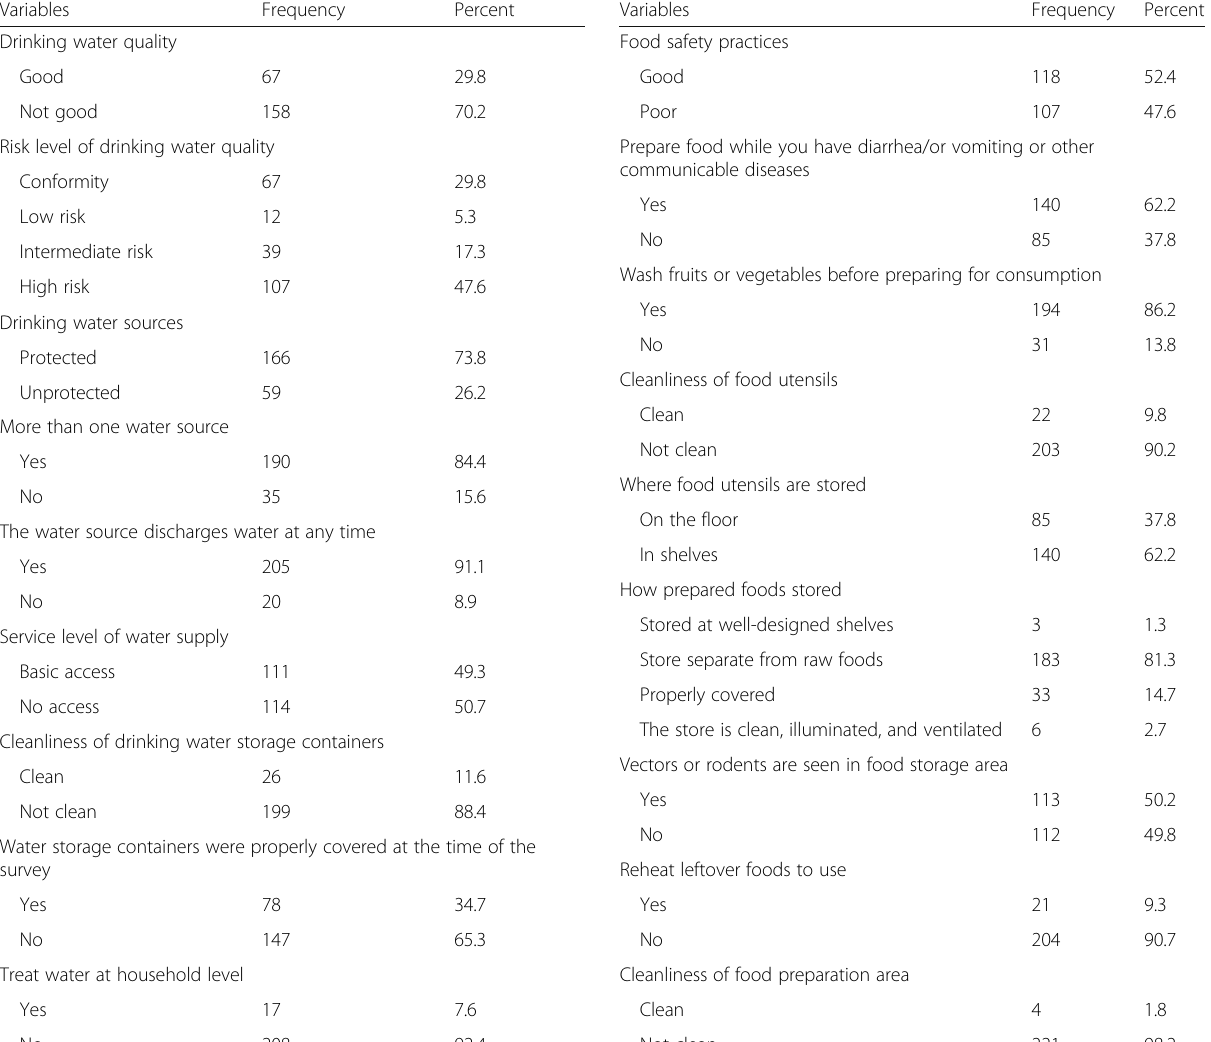
Table 4 Food safety practices of rural households in Dembiya, Table 3 Quality and access to drinking water in rural Dembiya,